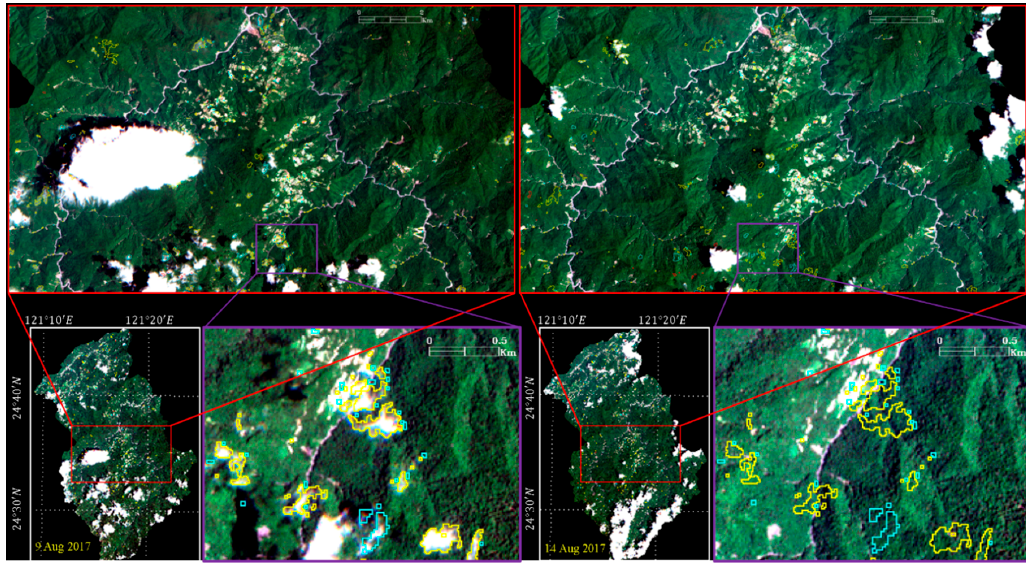
Figure 3. Example of automatic change detection of land use and land cover (LULC) in Jianshi